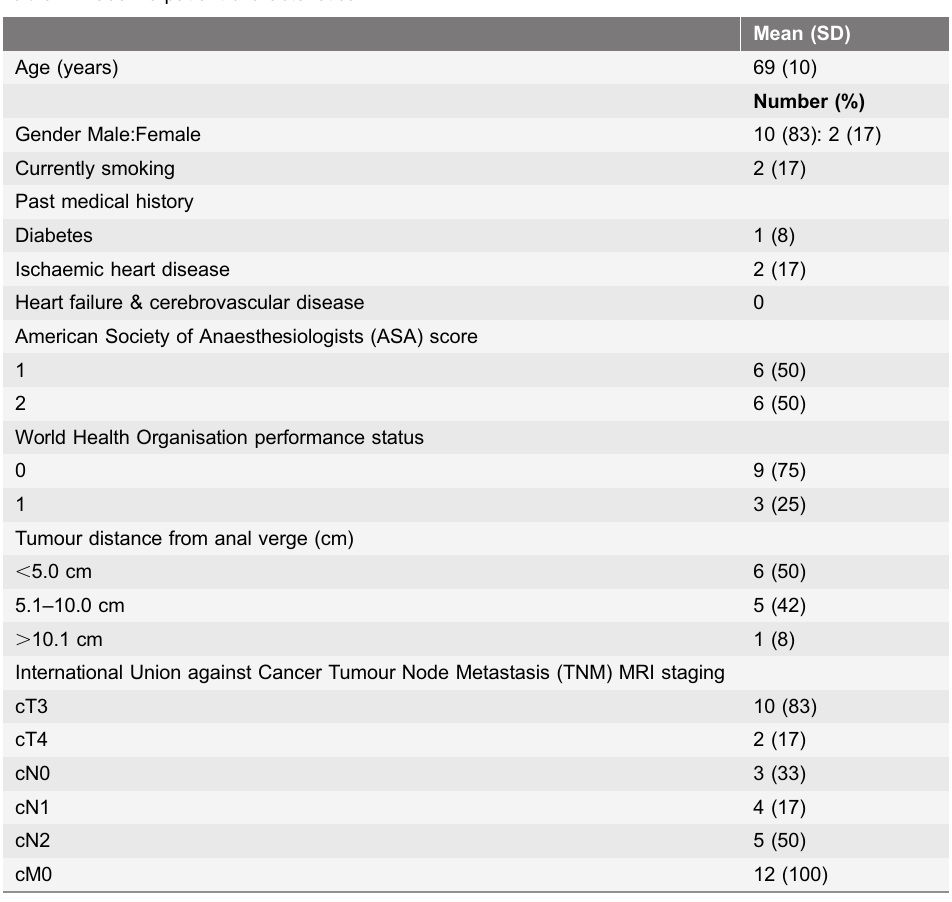
Table 1. Baseline patient characteristics.